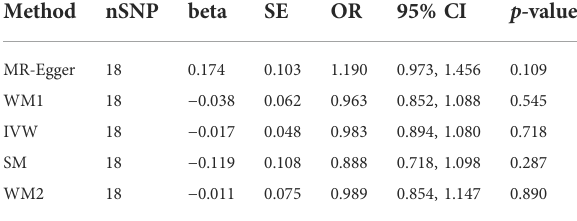
TABLE 3 Causal effect estimates of AS on AF from 5 MR